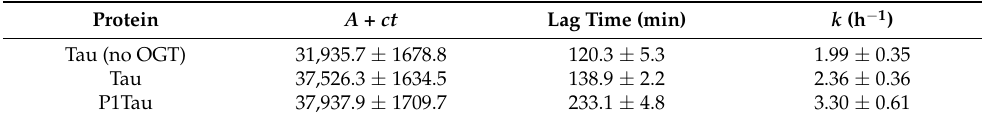
Table 2. Kinetic parameters of Tau and Tau-related protein aggregation in ThT binding assays. Protein